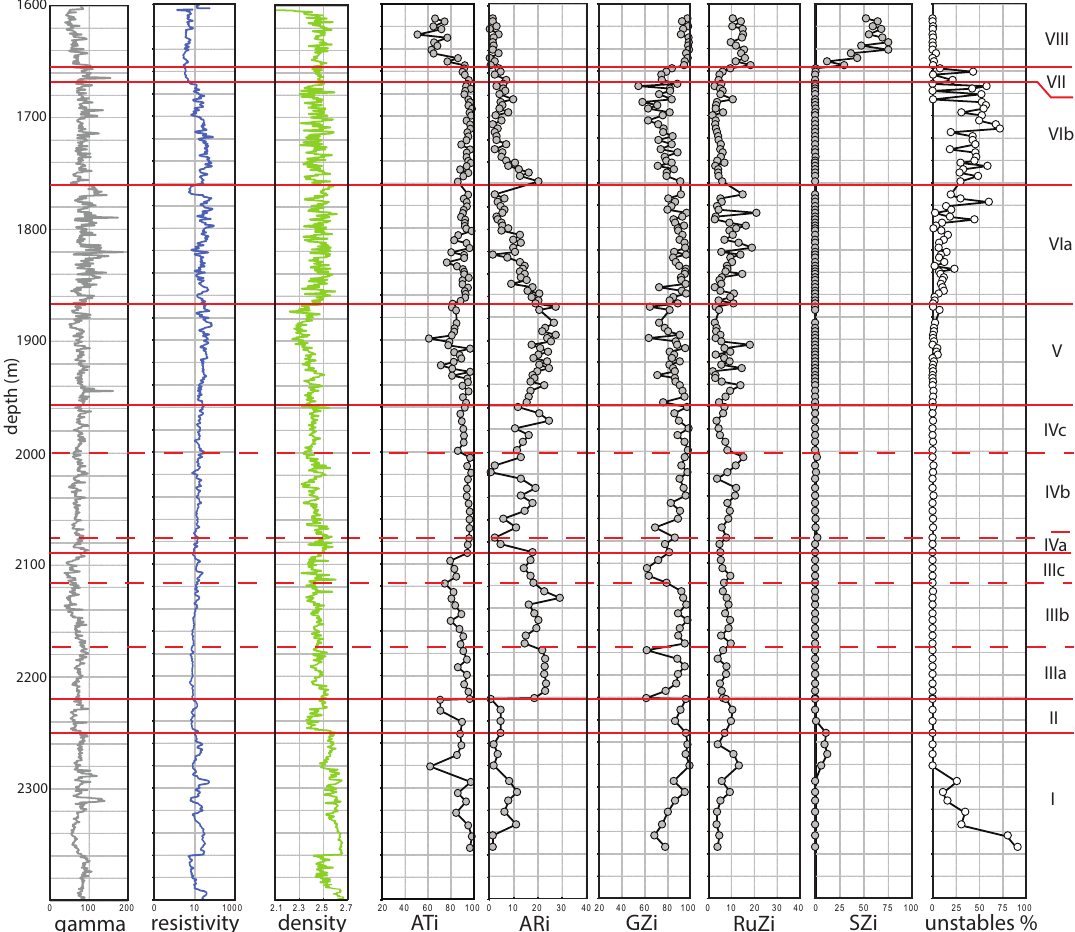
Figure 13. Heavy mineral stratigraphic framework for the Devonian-Carboniferous Clair Group reservoir succession in the Clair field, west of Shetland (Figure 1), illustrated using the fully cored well 206/8-8. Stratigraphic units (I, II, etc.) were originally defined by Allen and Mange-Rajetzky [37] and subsequently revised by Morton et al. [73] and Morton and Milne